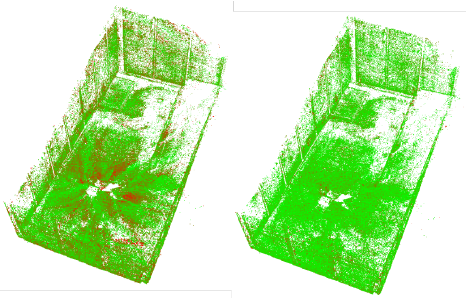
Figure 14. Image residual (reprojection error) estimated from camera orientation given by method 1 (left) and method 2 (right). Residual of tie points is represented in different colors (from 0 (pure green) to 1 (pure red))